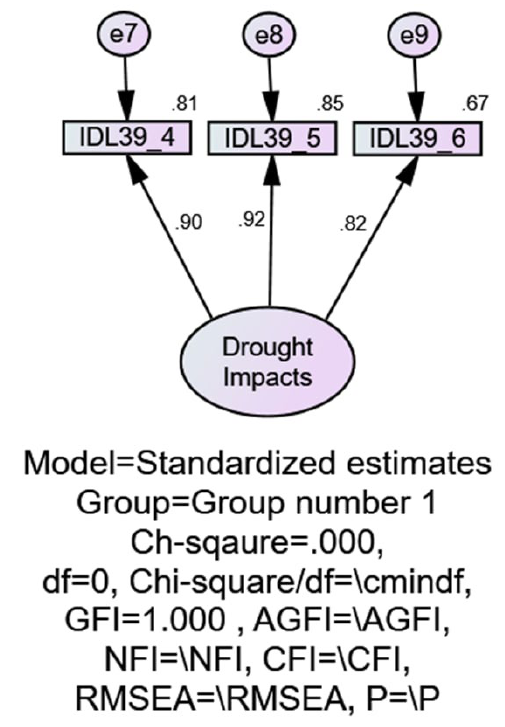
Figure A2. First-order factor model.